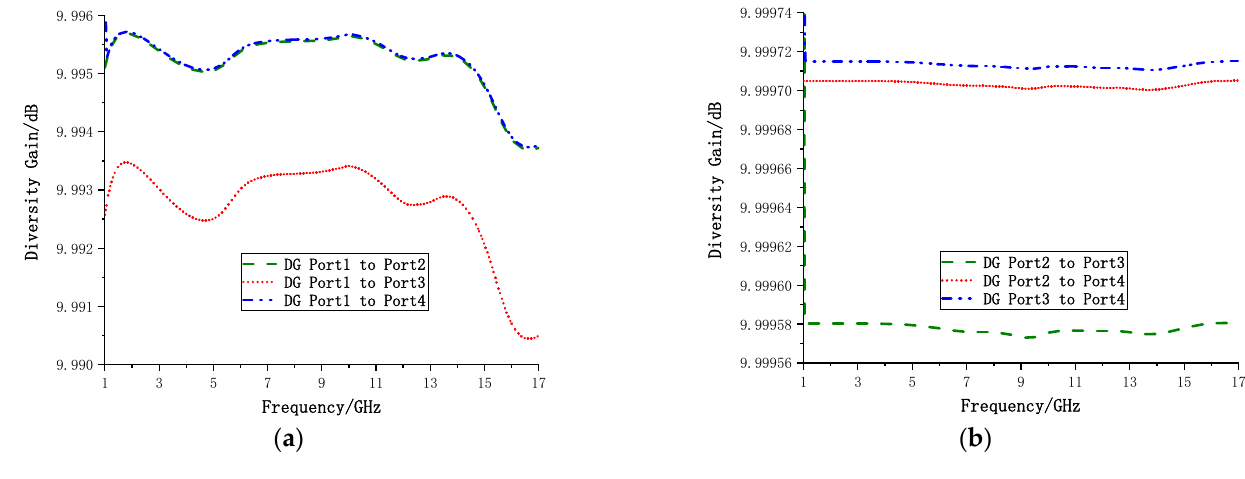
Figure 16. Diversity Gain curve of proposed antenna at: ( a ) port 1; ( b ) port 2.